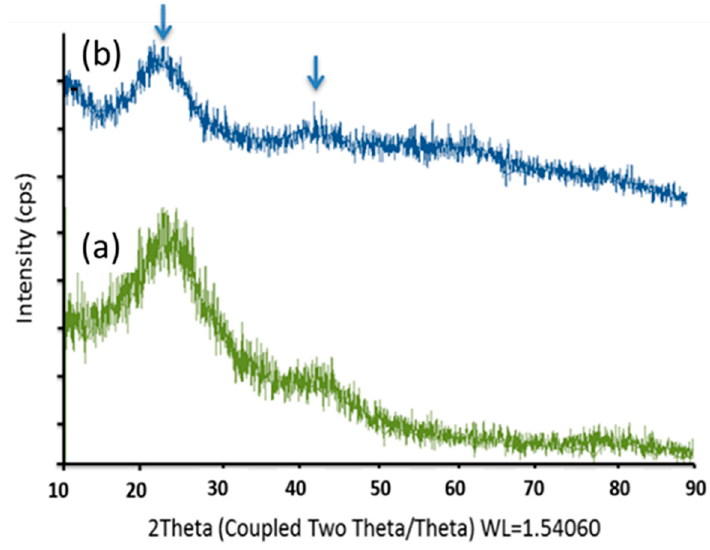
Figure 5. X-ray powder diffraction (XRD) patterns for ( a ) CF-SH and ( b ) CF-SH-Hg.